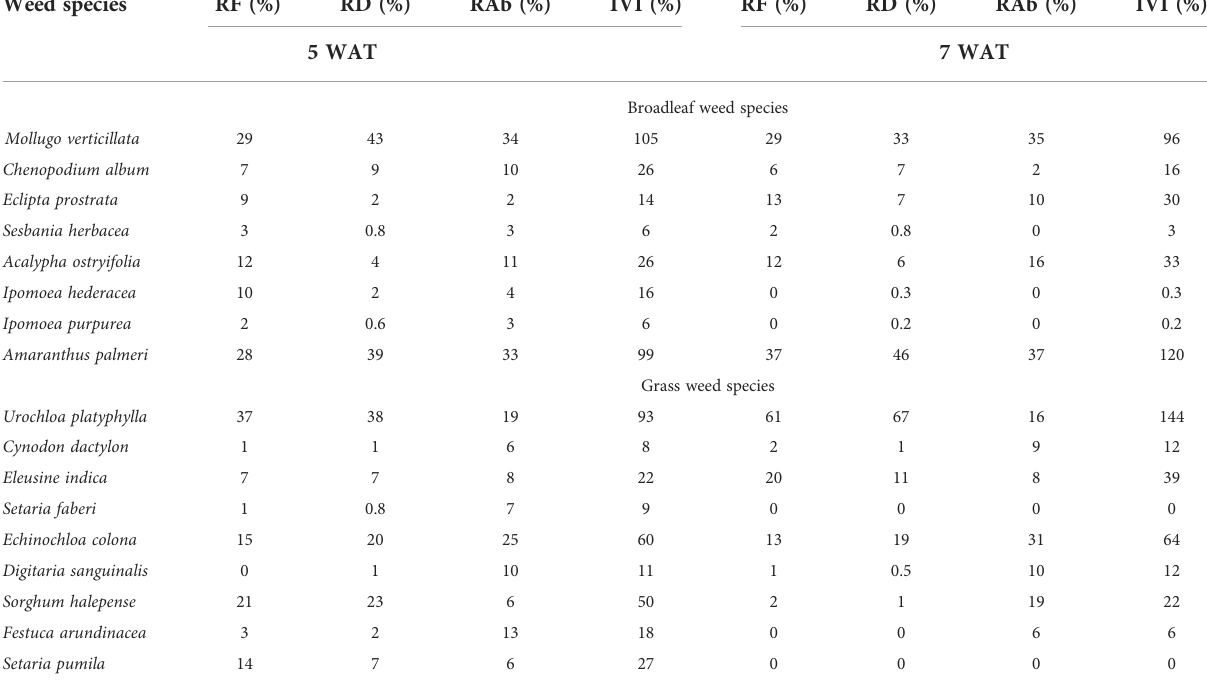
TABLE 5 Relative frequency (RF), relative density (RD), relative abundance (RAb), and importance value index (IVI) at 5 and 7 weeks after transplanting (WAT) in weedy plots with sweetpotato in Fayetteville, AR, 2021. Weed